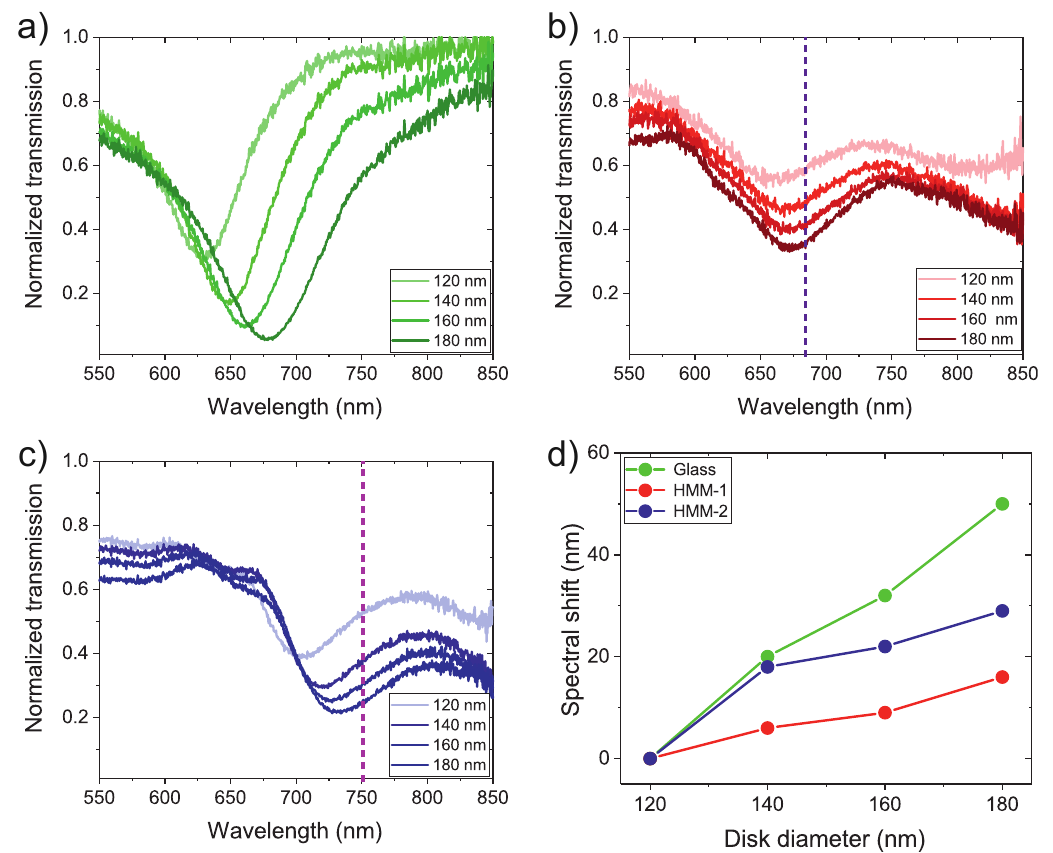
Figure 3: Normalized transmission spectra of the fabricated ND arrays, with disk diameters of 120, 140, 160 and 180 nm on three different substrates:(a)glass(green),(b)HMM-1(red)and(c)HMM-2(blue).TheENZpointsofHMM-1andHMM-2arehighlightedbyvioletandmagenta vertical dashed lines in the associated graphs, respectively. (d) The spectral shifts in the resonance wavelengths of the NDs on glass, HMM-1 and HMM-2. HMM, hyperbolic metamaterial; ND, nanodisk; ENZ,